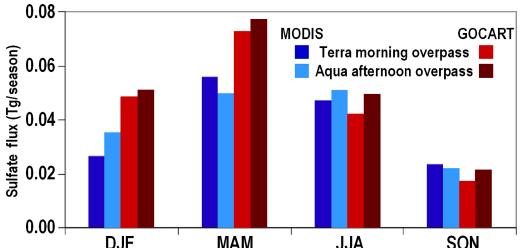
Figure 17. Seasonal flux (Tgseason − 1 ) of dry sulfate as derived from MODIS/Terra and MODIS/Aqua space-borne observations compared to GOCART model-derived results, along the 150km Is- raeli coastline of the eastern Mediterranean Sea. The seasons on the x axis are winter (DJF), spring (MAM), summer (JJA), and autumn (SON) (adapted from Rudich et al.,